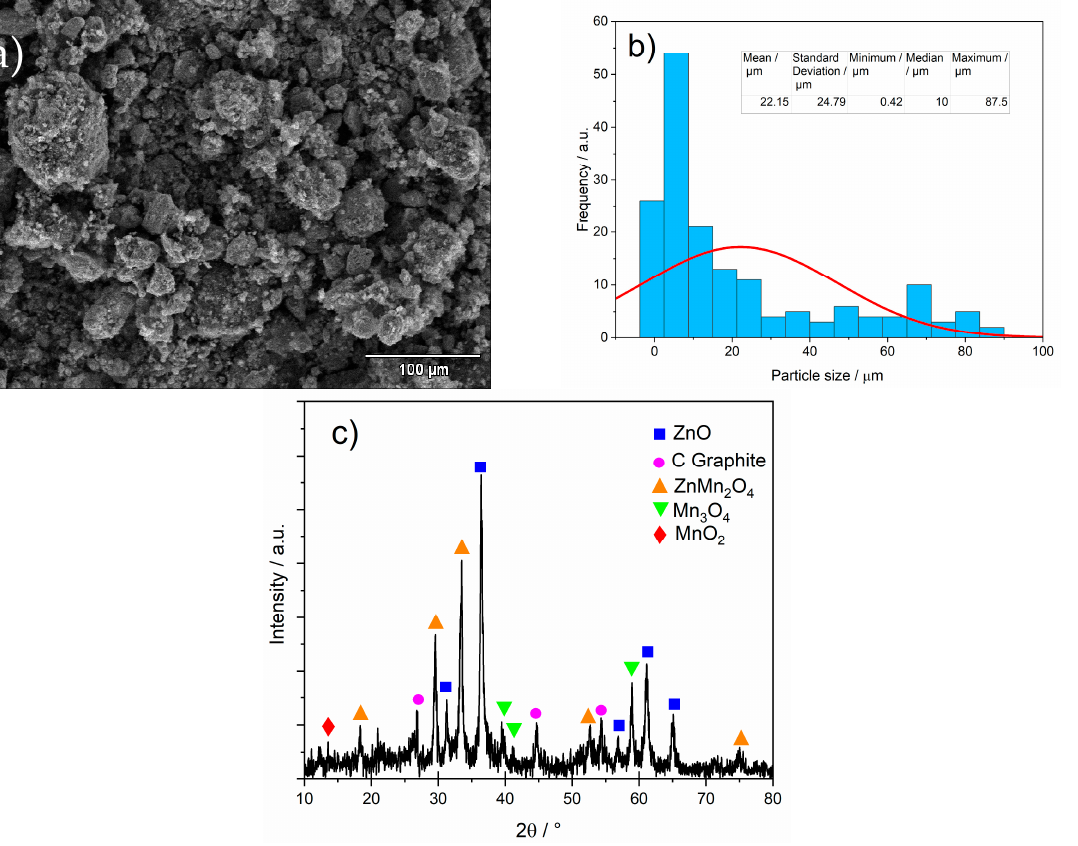
Figure 8. ( a ) Morphology of Zn–C battery powder by SEM: ( b ) particle size distribution, and ( c ) XRD pattern of the Zn–C battery powder.